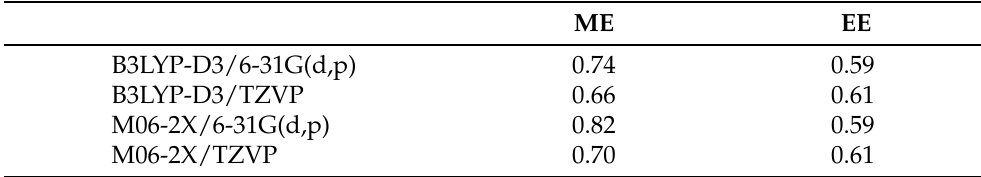
Table 4. RMSD (Å) between optimized geometries obtained by different ONIOM computations and the regular starting conformation (calf thymus B-DNA) for ss-C 4